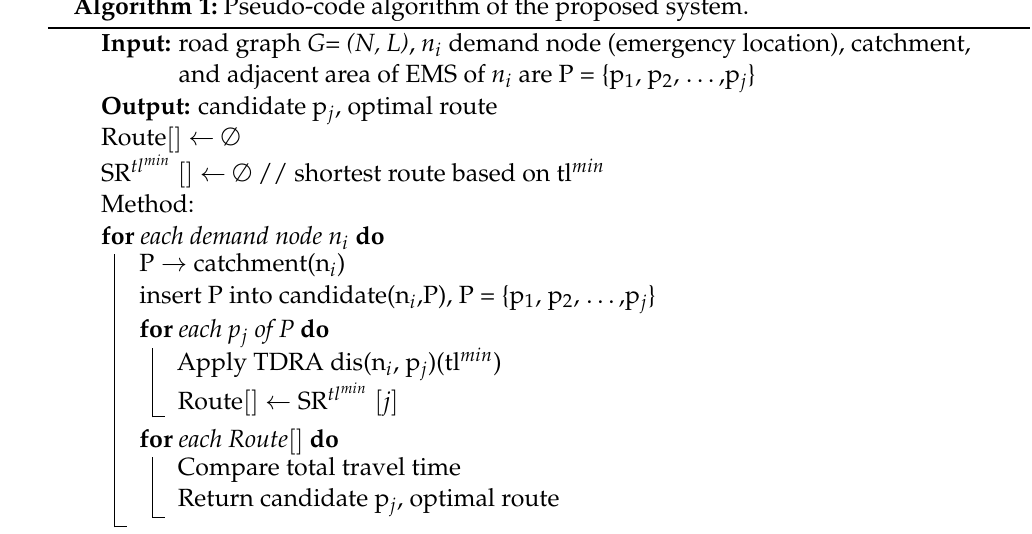
Algorithm 1: Pseudo-code algorithm of the proposed system.